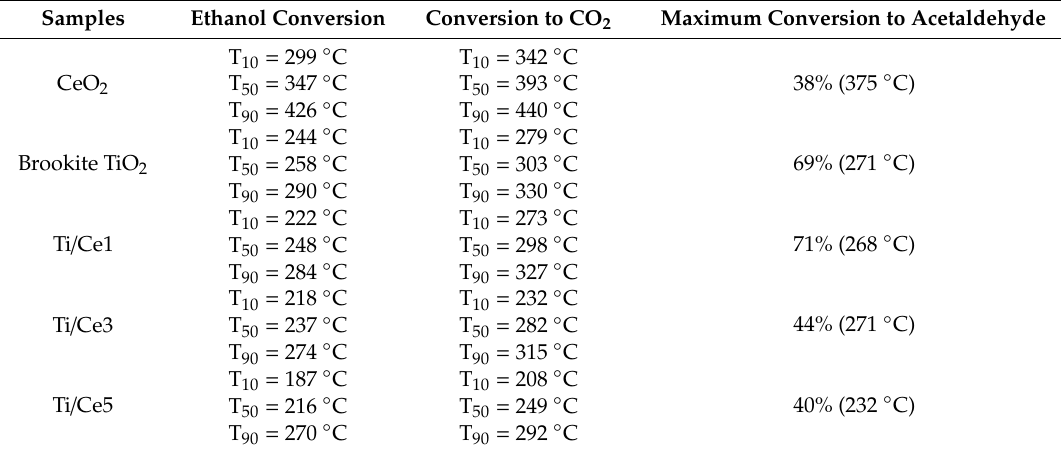
Table 5. Ethanol thermo-catalytic oxidation over the investigated samples.